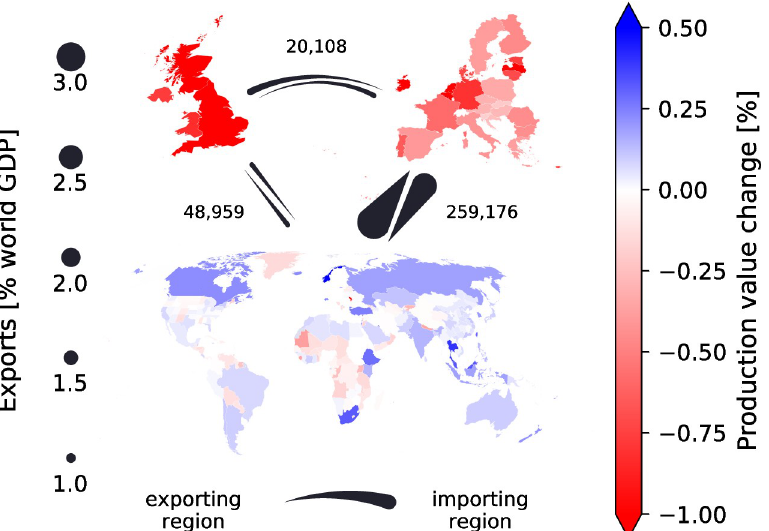
Fig 1. Production value changes after 30 days of a no-trade-deal event and trade relations between the UK, the EU and the rest of the world according to the underlying 2012 multi-regional Input-Output data. Maps show all countries and administrative units covered by our analysis. Thickness of arrows indicates how much is exported from one region to the other. Numbers above arrows state the number of trade connections between these two regions. In our simulations, we assume that trade between the UK and the EU is restricted to a certain percentage of the baseline values throughout the simulation period. Shading of colors is according to production value changes after 30 days of reduced border permeability. Changes shown here refer to a scenario of 70% border permeability. Complementary maps displaying changes in production quantities and prices after 30 days of a no-trade-deal event can be found in the Supplementary Materials (S2 Fig in S1